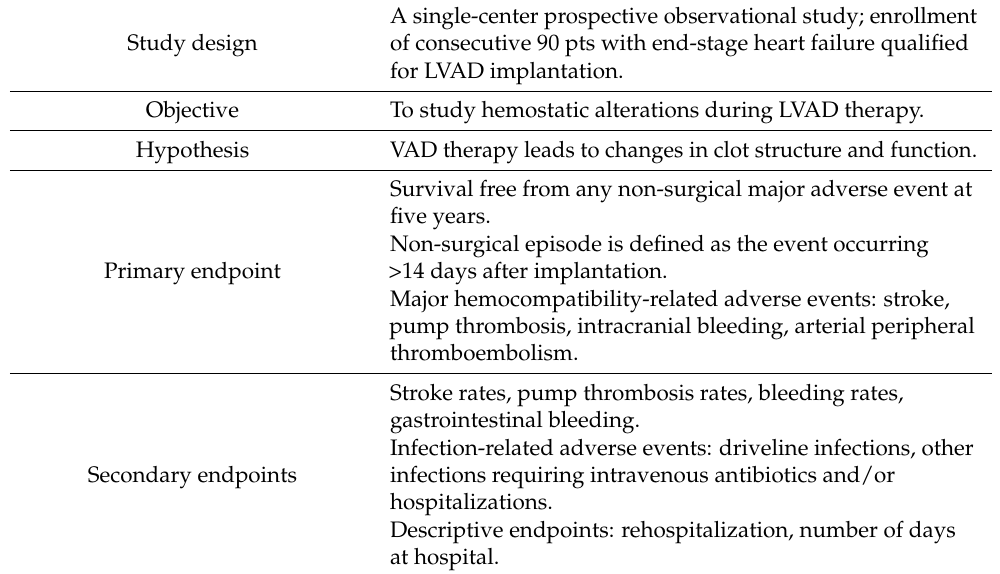
Table 3. Summary of the clinical